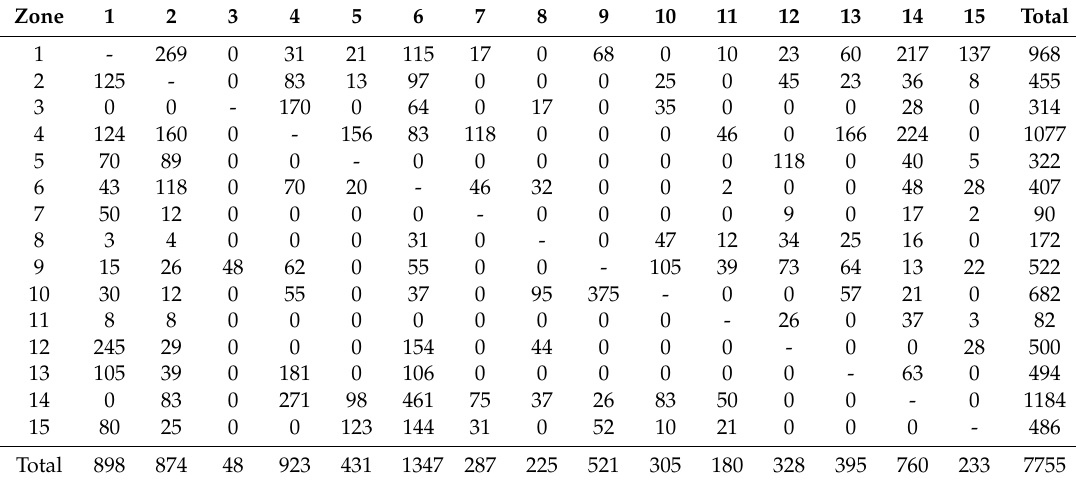
Table 3. O–D trip matrix per defined